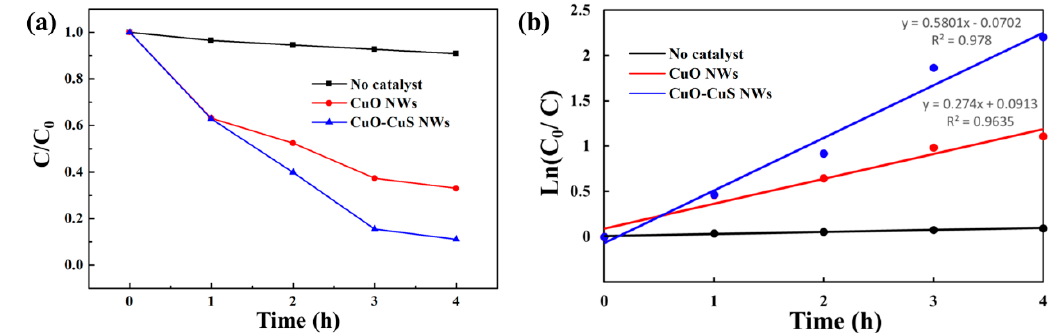
Figure 6. ( a ) Relative concentration (C/C 0 ) of MB versus visible light irradiation time, and ( b ) ln(C 0 /C) versus time for kinetic analysis of MB degradation.